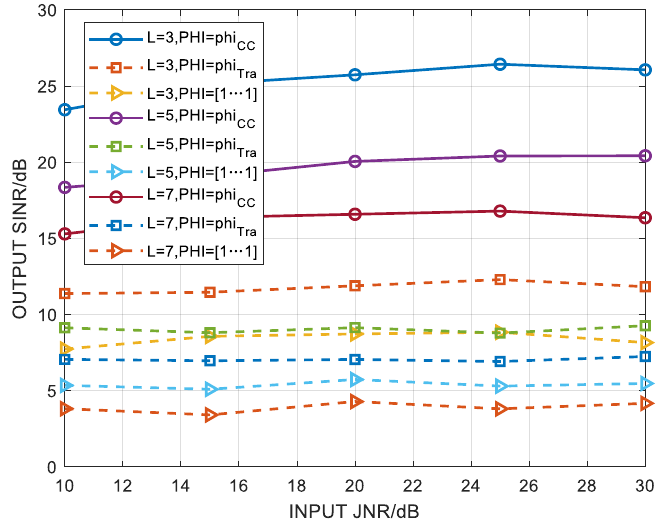
Figure 5. Comparison of the number of paths to the anti-jamming reception performance of different algorithms.